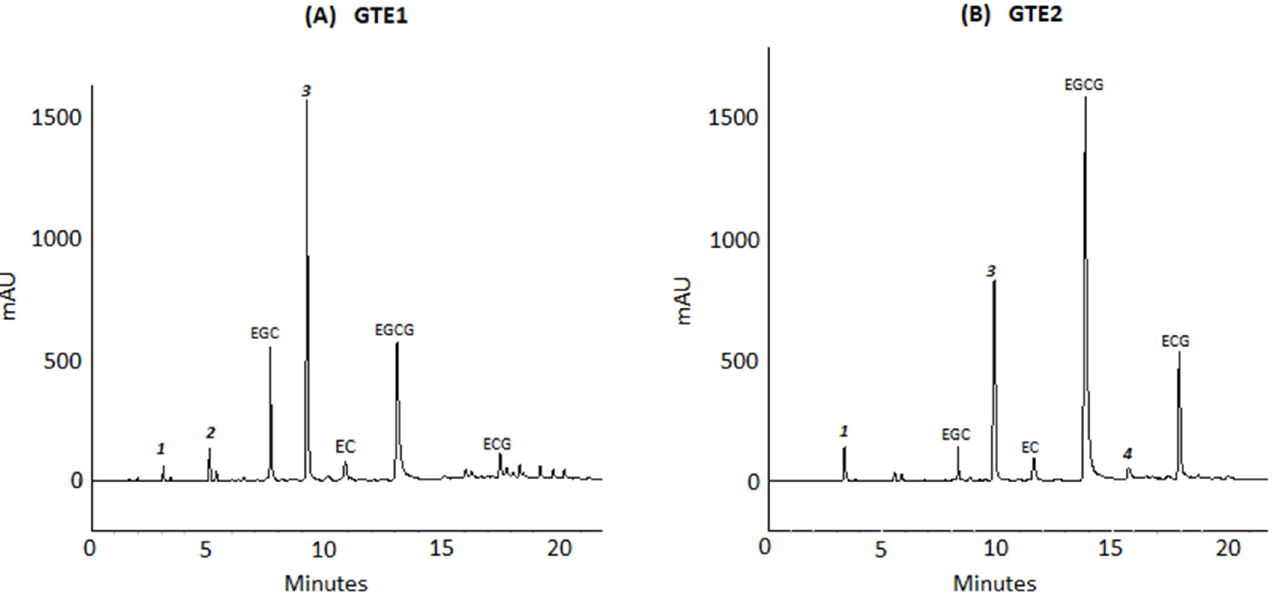
Figure 2. Chromatographic separation of catechins from two green tea extracts, GTE1 ( A ) and GTE2 ( B ). A binary solvent gradient system with solvent A (1% formic acid in water) and solvent B (1% formic acid in acetonitrile) was used. Identified and quantified compounds: EGC = epigallocatechin, EC = epicatechin, EGCG = epigallocatechin gallate, ECG = epicatechin gallate. Other compounds 1= gallic acid, 2 = gallocatechin, 3 = caffeine, 4 = gallocatechin gallate.